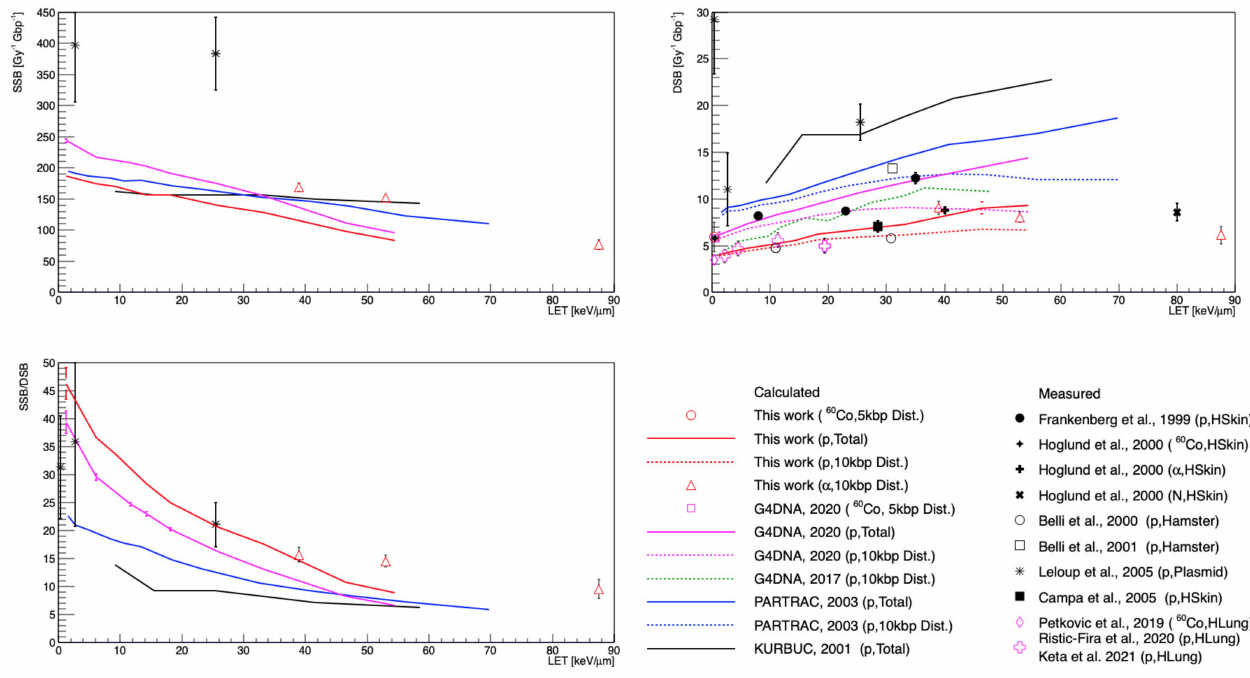
Figure 4. The SSB ( left upper) and DSB yields ( right upper), and SSB/DSB ratio ( left below) as a function of LET for the MCTS simulations and